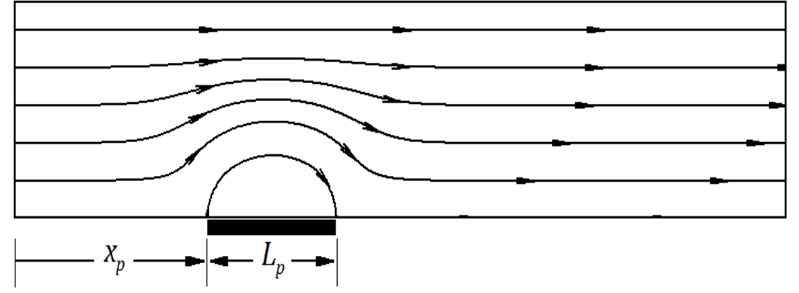
Figure 1. Streamlines related to the simplest heterogeneous microchannel